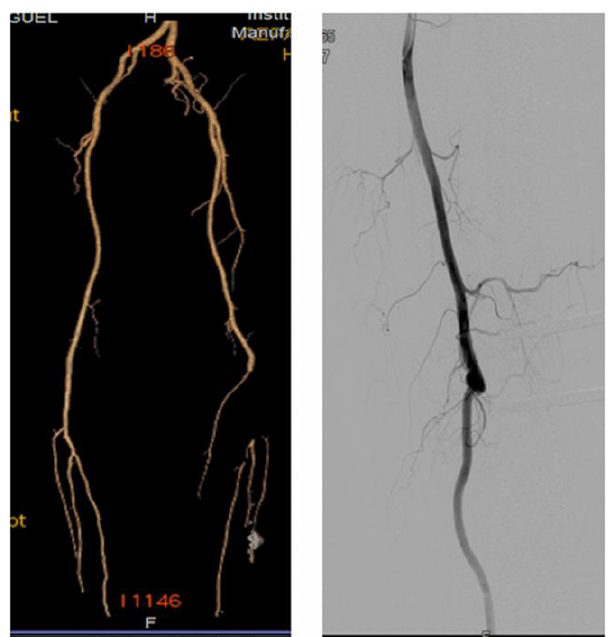
Figure 2: Angio-CT scan showing complete obliteration of the left popliteal artery at the level of the femoral condyles, without observing contrast leakage. Distal repermeabilization of the three tibioperoneal trunks is